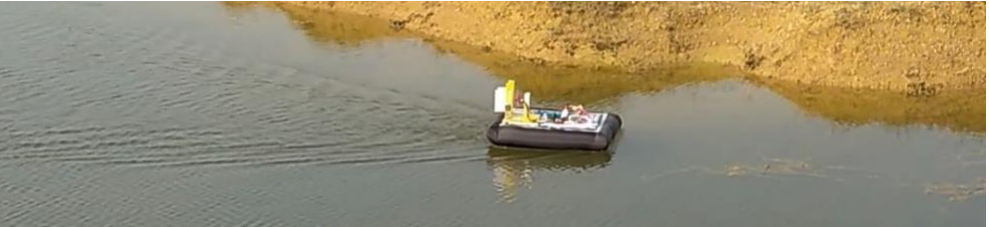
Figure 17. Testing of hovercraft in water